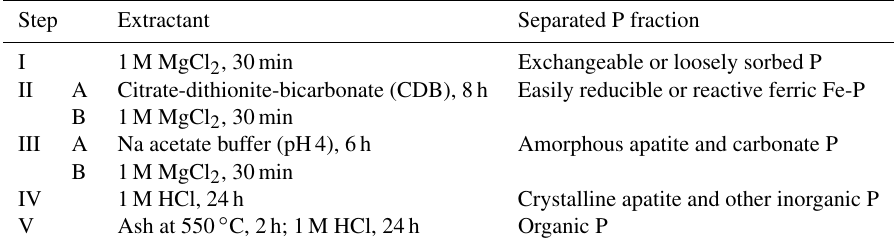
Table 1. List of steps used in the extraction procedure of phosphorus (based on Ruttenberg, 1992). Step Extractant Separated P fraction I 1M MgCl 2 , 30min Exchangeable or loosely sorbed P II A Citrate-dithionite-bicarbonate (CDB), 8h Easily reducible or reactive ferric Fe-P B 1M MgCl 2 , 30min III A Na acetate buffer (pH4), 6h Amorphous apatite and carbonate P Crystalline apatite and other inorganic P Organic